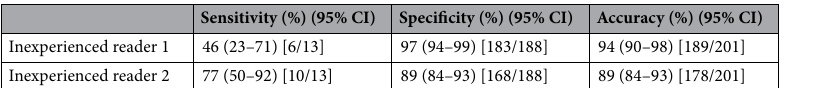
Table 3. Diagnostic performance of newly detected pituitary adenoma on 1 mm DLR MRI, which was not visualised on 3 mm routine MRI. 95% CI = 95% confidence interval, 1 mm DLR MRI = 1 mm slice thickness MRI with deep learning-based reconstruction, 3 mm routine MRI = 3 mm slice thickness